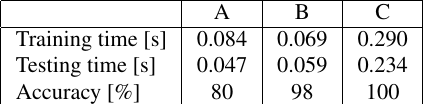
Comparison of the computation times for the Col- orChecker dataset. A: MLM (cosine, variance, training set size 2500, R size 250), higher threshold: > 0.5. B: MLM (cosine, variance, training set size 2500, R size 250), lover threshold